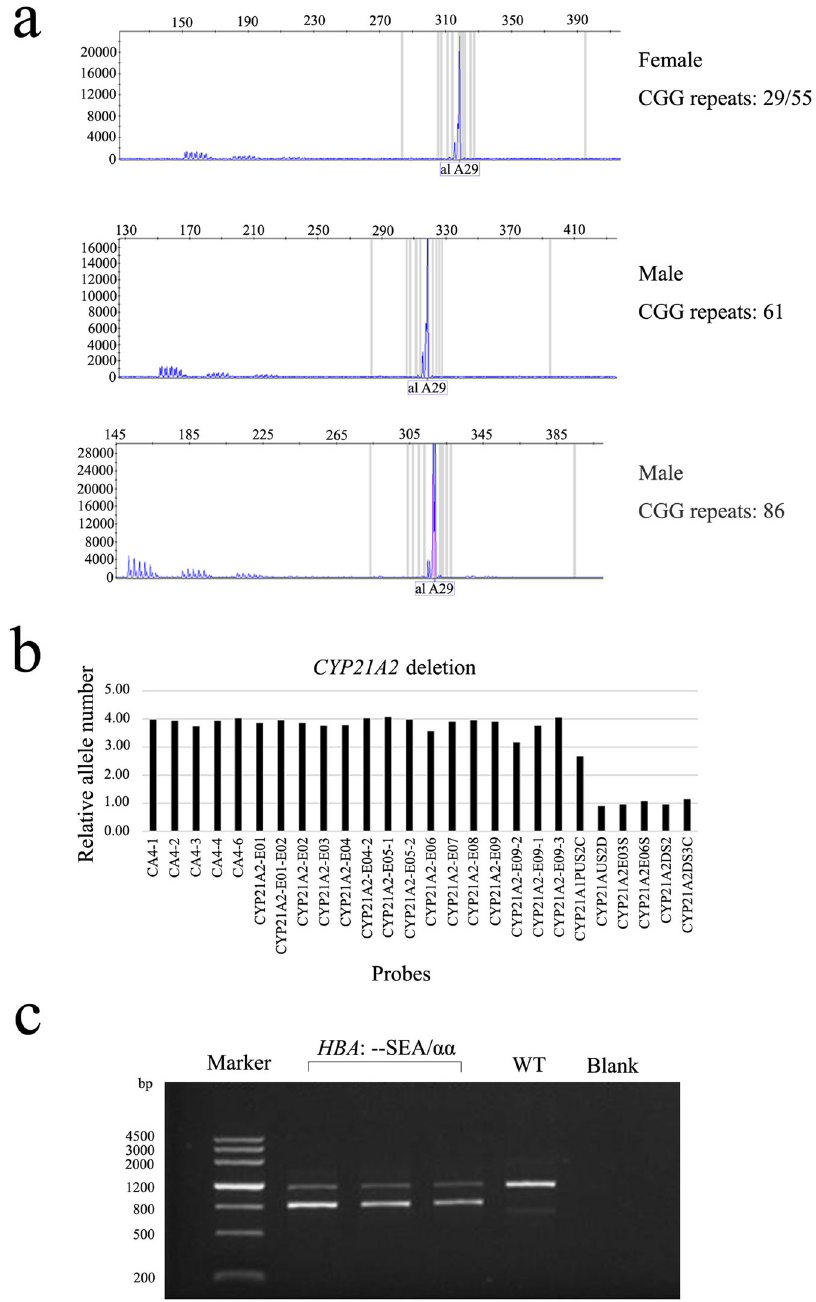
Fig. 2 Representative images of variants detected by different methods. a Con fi rmation of FMR1 CGG repeats in three carriers with premutation using the Asuragen AmplideX ™ FMR1 PCR Kit. The image showing hexachloto-Fluorescein (HEX) channel from capillary electrophoresis. b Analysis of CYP21A2 deletion by using HLPA. The shown columns are relative allele number of CYP21A2 exons. c Gap-PCR analysis was performed to analyze of HBA1 deletions. A representative gel image of banding pattern observed for HBA1 --(SEA) deletion is shown. WT wide